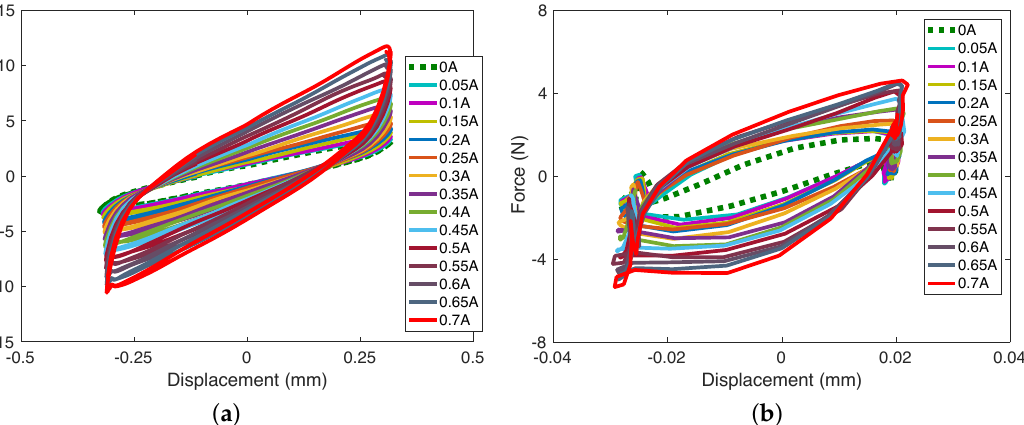
Figure 7. Measured damper force of the MRE-DVA versus the displacement (for a 3 mm pad Figure 6: Measured damper force of the MRE-based DVA versus the displacement. Figure 6: Measured damper force of the MRE-based DVA versus the displacement. thickness): ( a ) at 0.1 Hz and ( b ) at 150